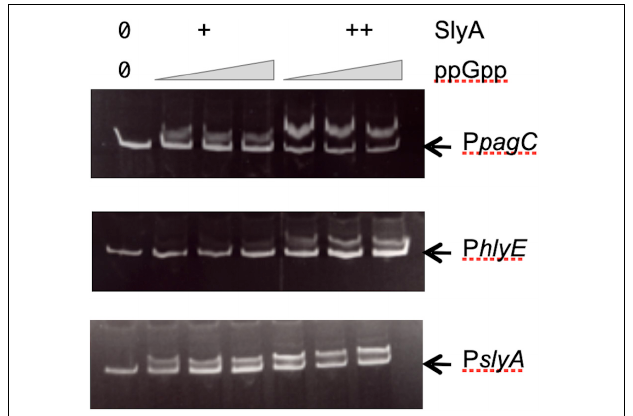
FIGURE 4 | Effect of ppGpp on SlyA binding to DNA. Electrophoretic mobility shift assays were performed using purified SlyA from E. coli [at 50 (+) or 100 (++) nM] or purified SlyA from Salmonella for the pagC experiment [at 200 (+) or 400 (++) nM]. For each SlyA concentration, 0, 50, or 100 µ M ppGpp were